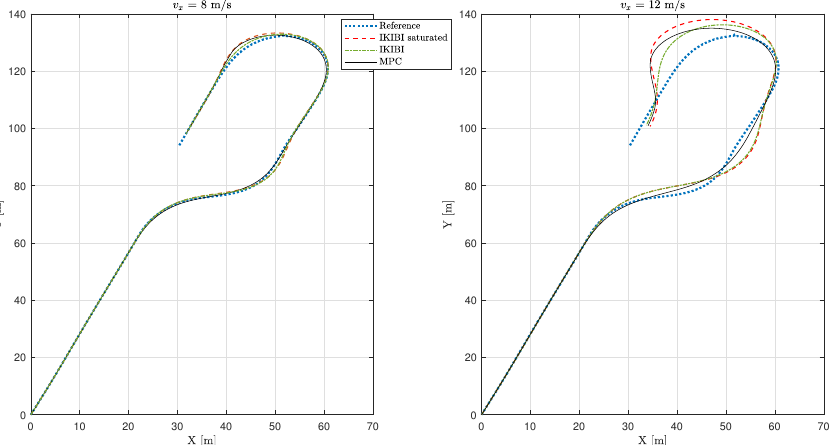
Figure 3. Vehicle path: noiseless, fast sensor feedback test. ( left ) v x = 8 m/s and ( right ) v x = 12 m/s.